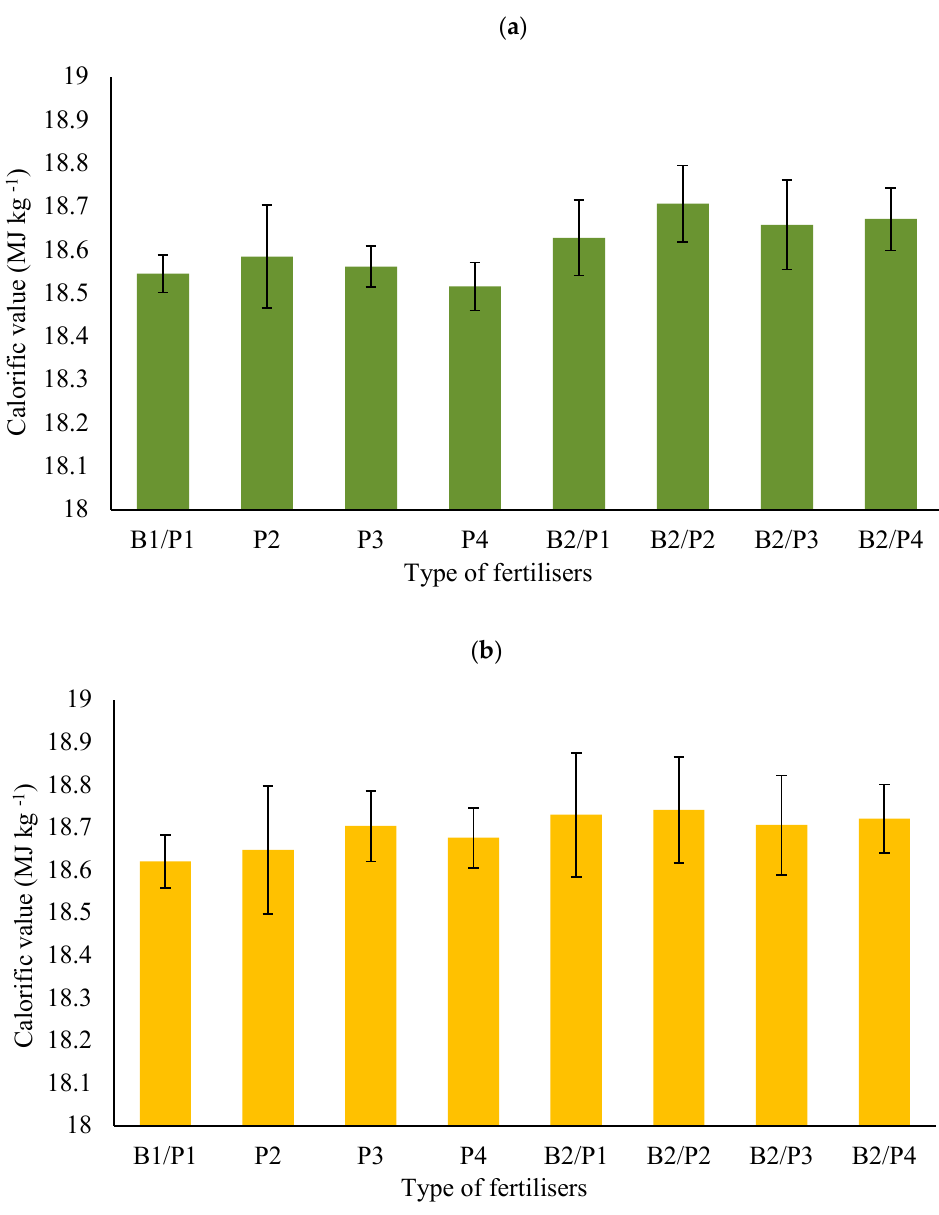
Figure 6. Calorific value of basket willow at the end of the first ( a ) and the second ( b ) year of cultivation, in relation to the fertiliser